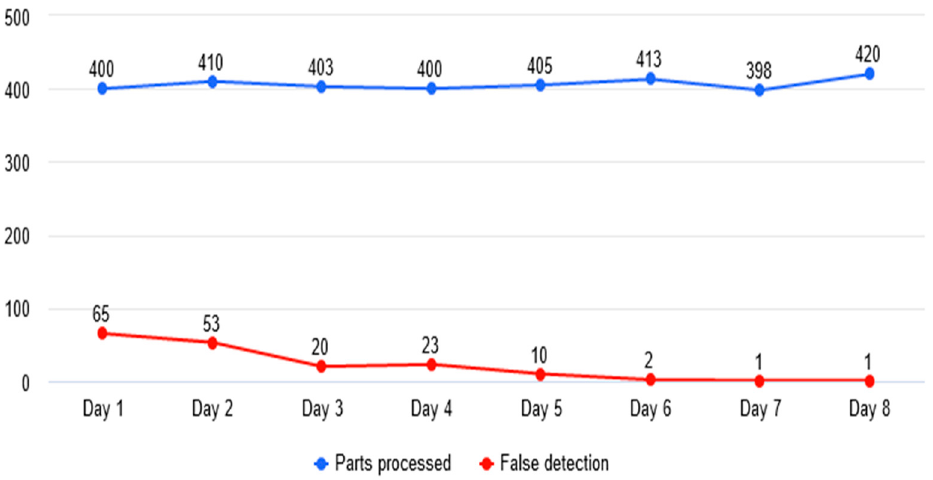
Figure 9. Evolution of false detections.